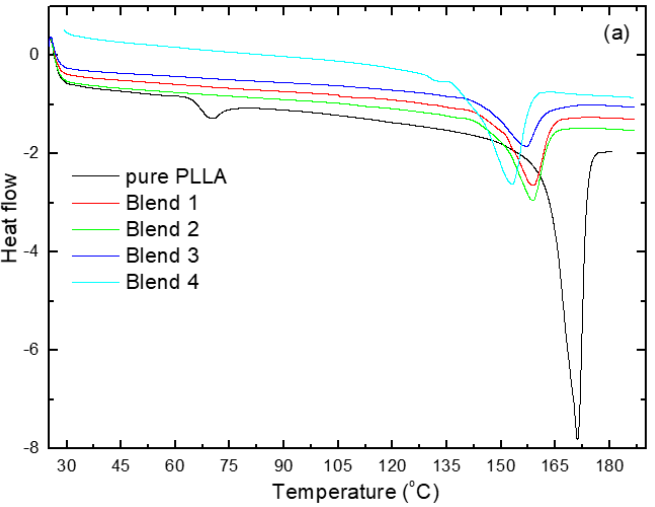
Table 2. Thermal properties of pure PLLA and its blends at different concentrations. F.H.: first heating, S.H.: second